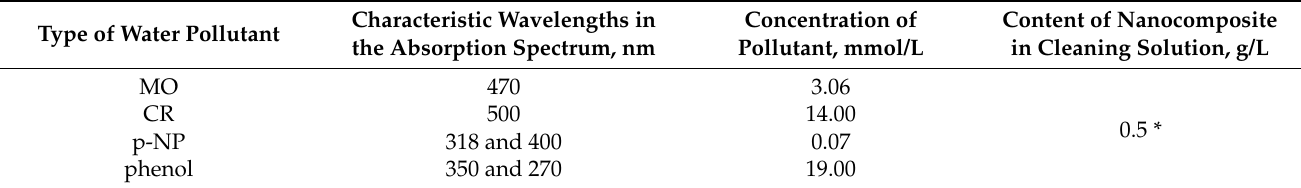
Table 3. Component ratios in photocatalytic cells depending on the type of water pollutant. Characteristic Wavelengths in Concentration of Content of Nanocomposite Type of Water Pollutant the Absorption Spectrum, nm Pollutant, mmol/L in Cleaning Solution, g/L MO 470 3.06 *CR 500 14.00 0.5 p-NP 318 and 400 0.07 phenol 350 and 270